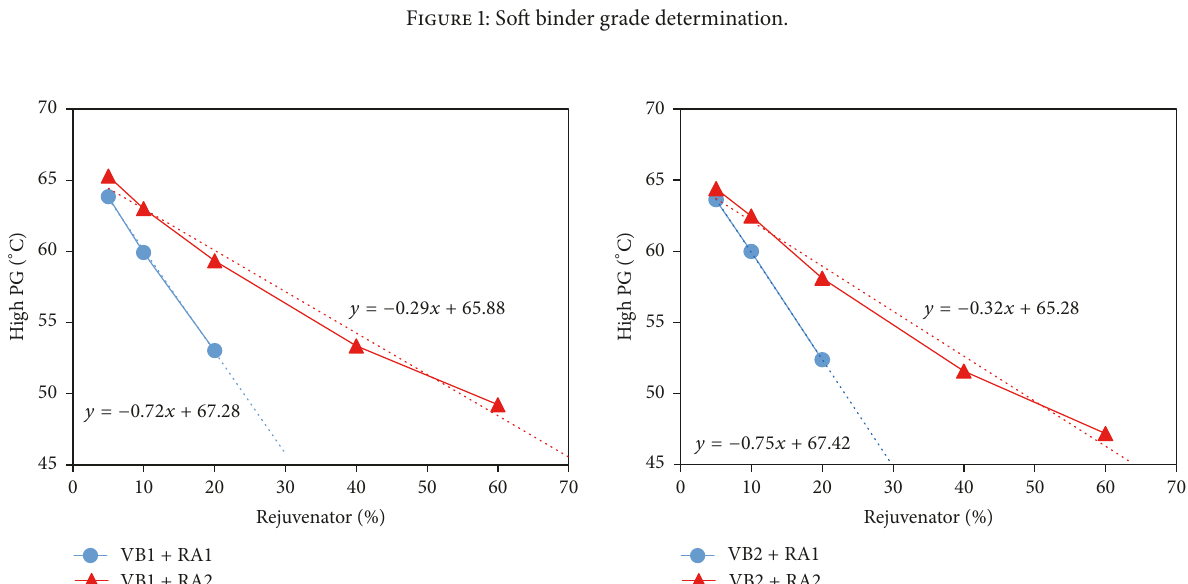
Figure 2: Softening